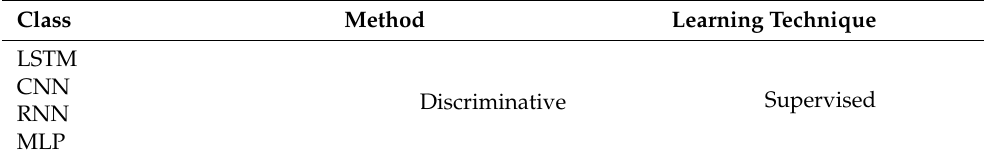
Table 1. Various classes and methods of machine and deep learning techniques.